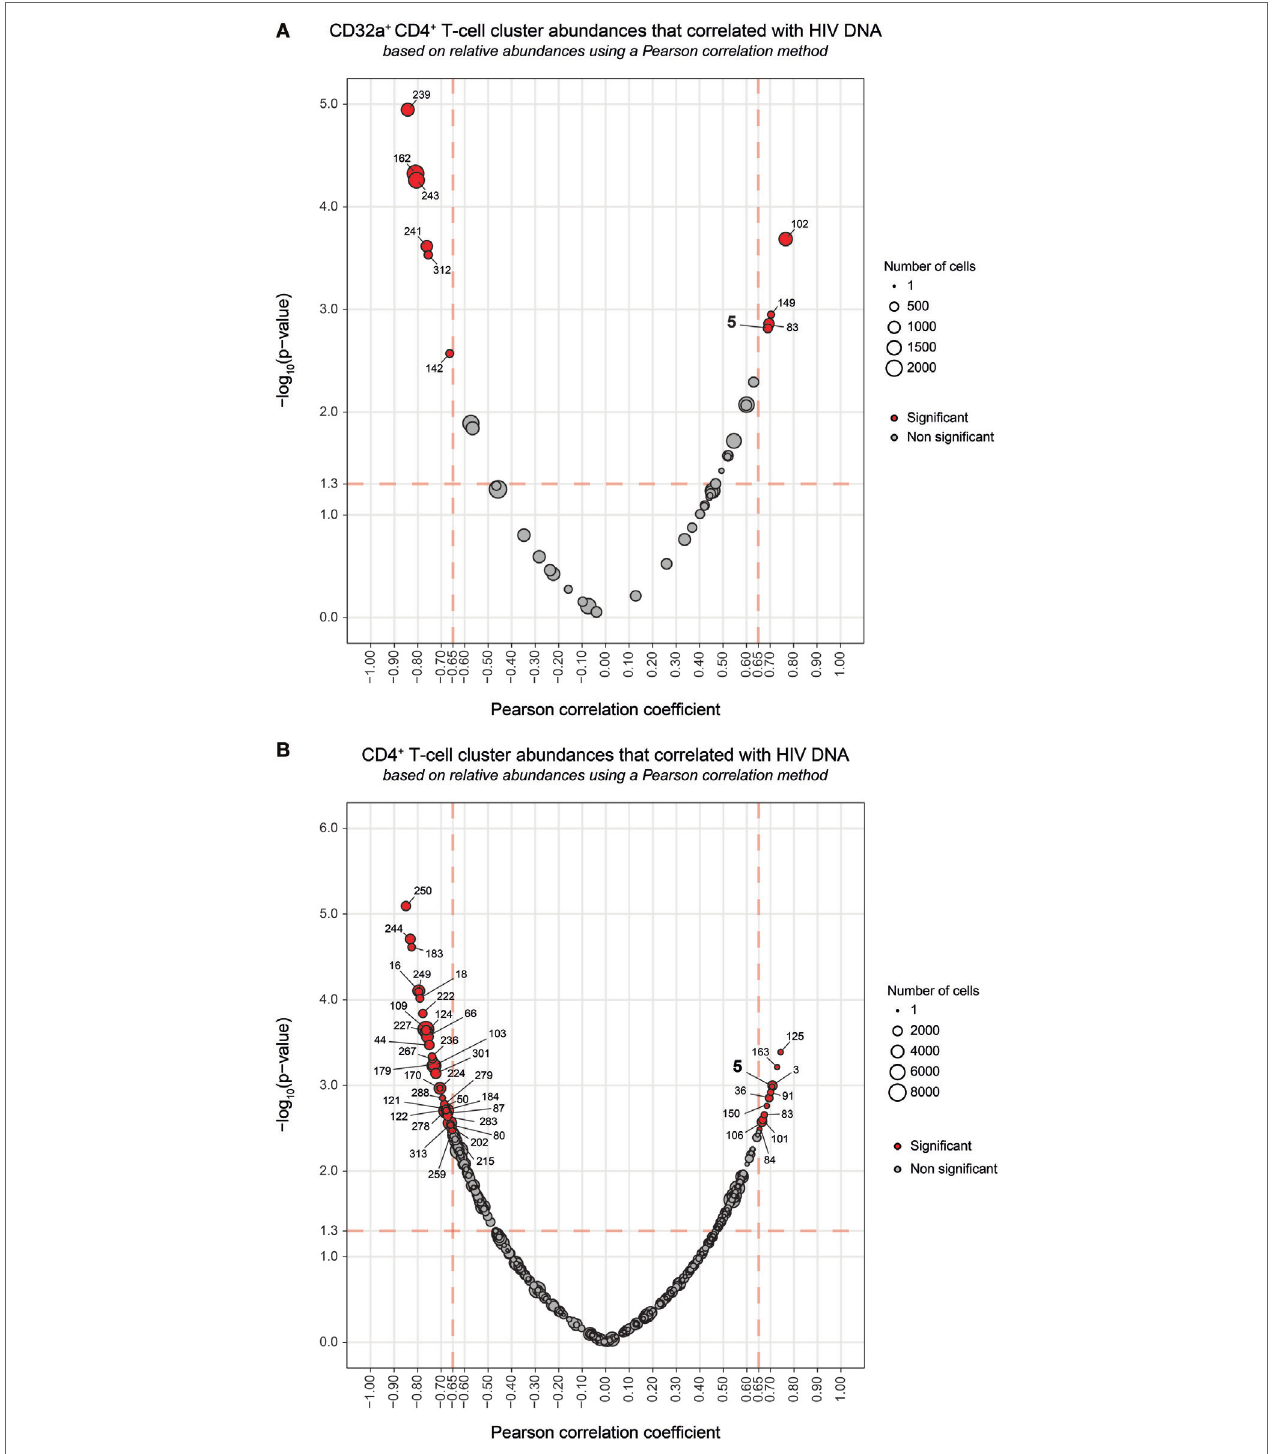
FigUre 4 | Correlation analyses of CD32a + CD4 + and CD4 + T-cell cluster abundances with HIV DNA levels. (a,B) Correlations were based on the number of cells associated with each cluster relative to the number of cells in the parent population, corresponding to CD32a + CD4 + T cells or CD4 + T cells, respectively. Clusters having an abundance positively (right) or negatively (left) correlated with total HIV DNA levels are represented in red. The two-dimensional charts represent the association between the cell abundance and total HIV DNA for each cluster using the Pearson correlation coefficient and associated p -value. Each dot in the representation corresponds to a cell cluster. Significantly correlated clusters are indicated in red with a Pearson correlation coefficient > 0.65 and a p -value < 0.05. The size of the dot is proportional to the number of cells of the whole dataset associated with the cluster. The Pearson correlation coefficient is represented on the X -axis and the associated p -value, shown as − log10, on the Y -axis. Cluster #5 is indicated in